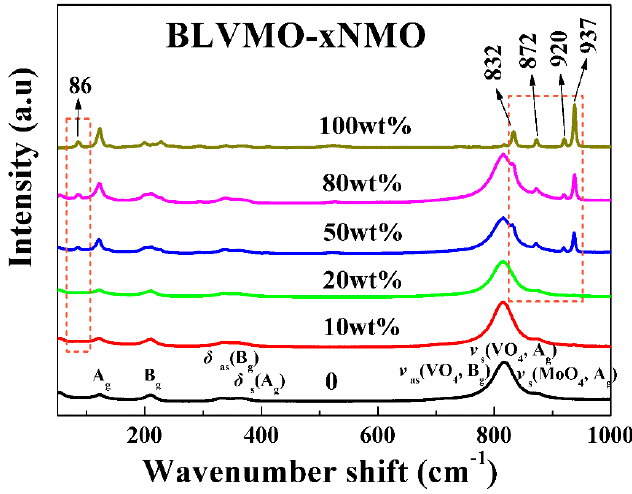
Figure 3. Raman spectra of (100 − x) wt.% BLVMO-x wt.% NMO ceramic composites.